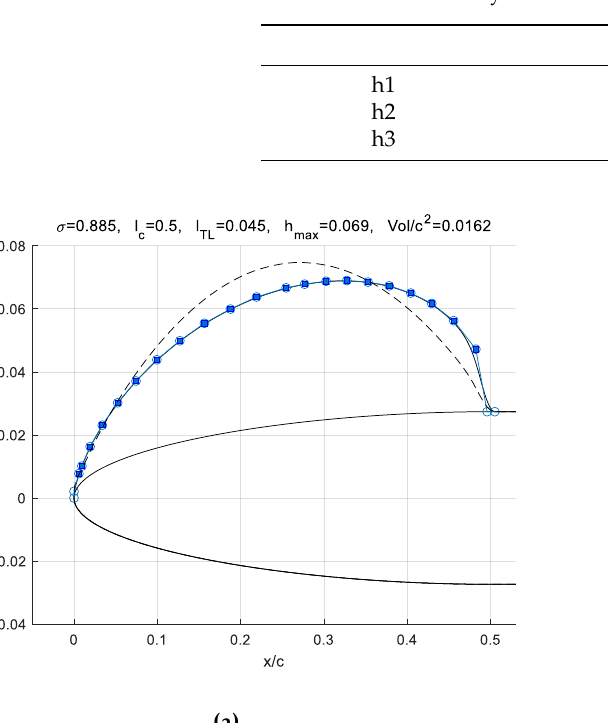
Table 1. Effects of cavity initialization on the solution.